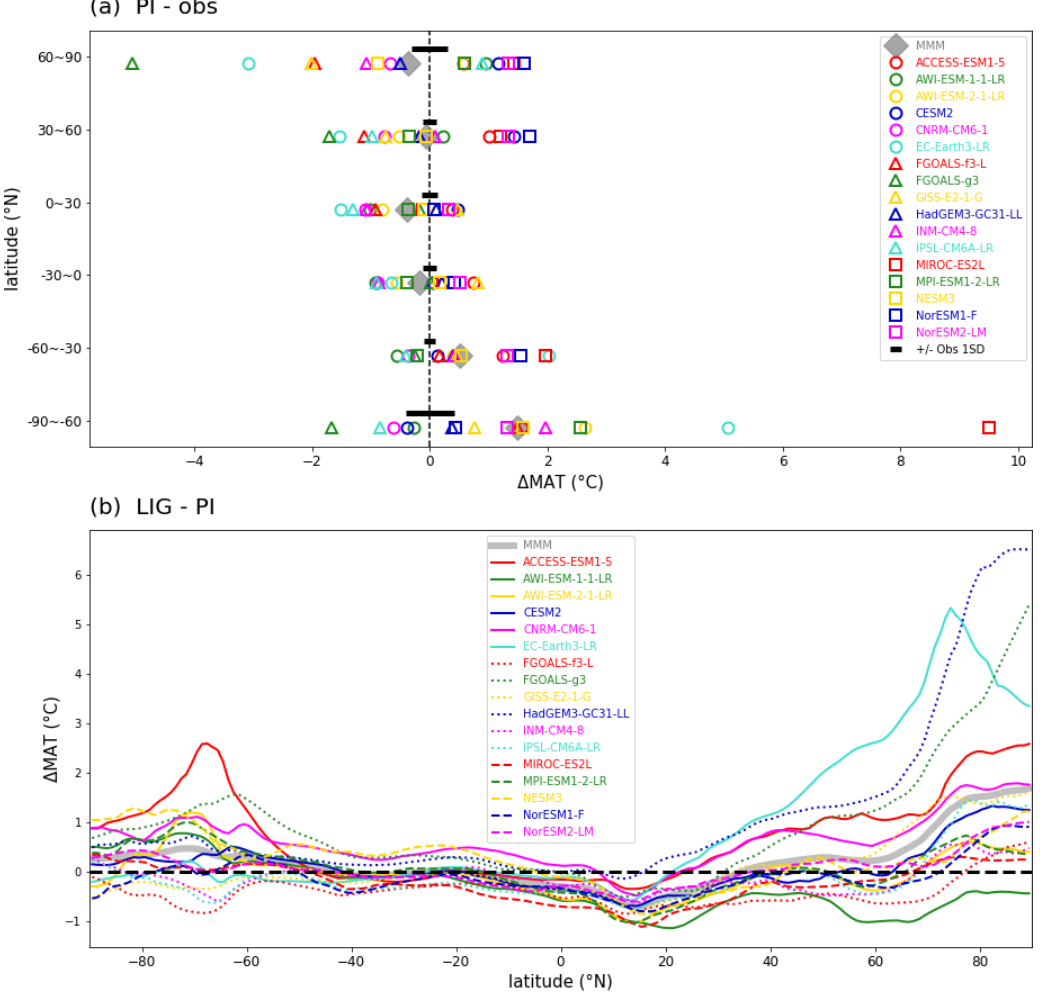
Figure 2. (a) Comparison of the preindustrial zonal mean temperature profile of individual climate models and MMM to the 1850–1900 observations. The area-averaged, annual mean surface air temperature for 30 ◦ latitude bands in the CMIP6 models and a spatially complete compilation of instrumental observations over 1850–1900 (black; Ilyas et al., 2017; Morice et al., 2012). (b) Changes in zonal average, mean annual surface air temperatures ( lig127k minus piControl)